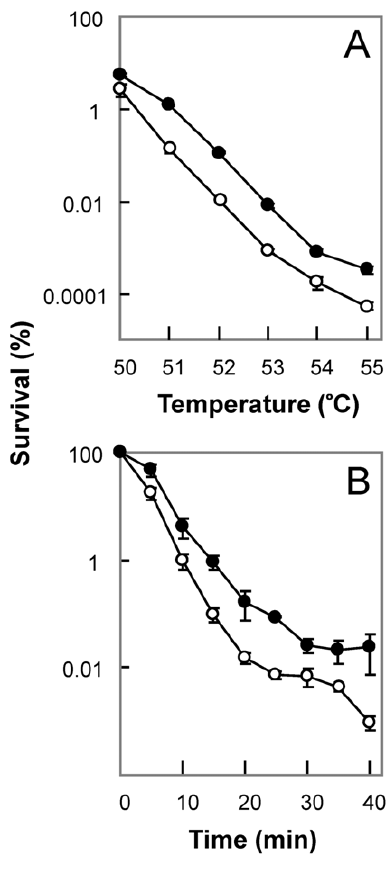
Figure 4. Effect of ndoA deficiency on bacterial survival during high-temperature treatment. Overnight cultures of wild-type B. subtilis strain (BD630, filled circles) and its D ndoA mutant (3169, open circles) were concentrated by centrifugation, washed in saline (0.9% NaCl), resuspended and serially diluted in saline, and incubated at the indicated temperatures for 20 min (panel A) or for the indicated times at 52 u C (panel B). After incubation, the cultures were diluted and applied to LB agar plates for colony determination. Error bars indicate standard deviation. Similar results were obtained in replicate